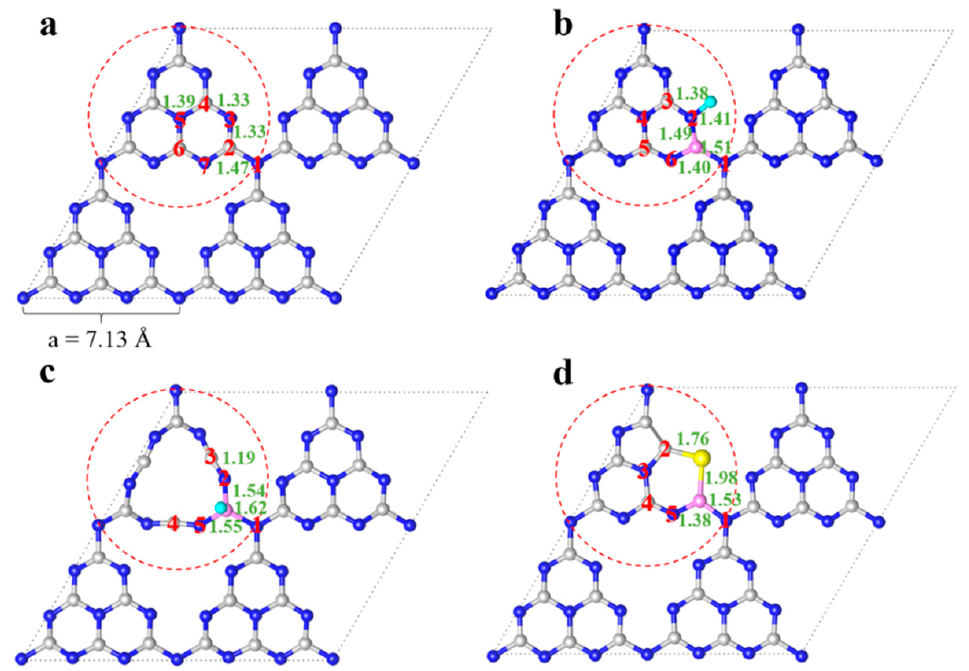
Figure 2. The optimized geometries and bond lengths of g-C 3 N 4 ( a ), B-F ( b ), B-F-N v ( c ), and B-S-N v ( d ).